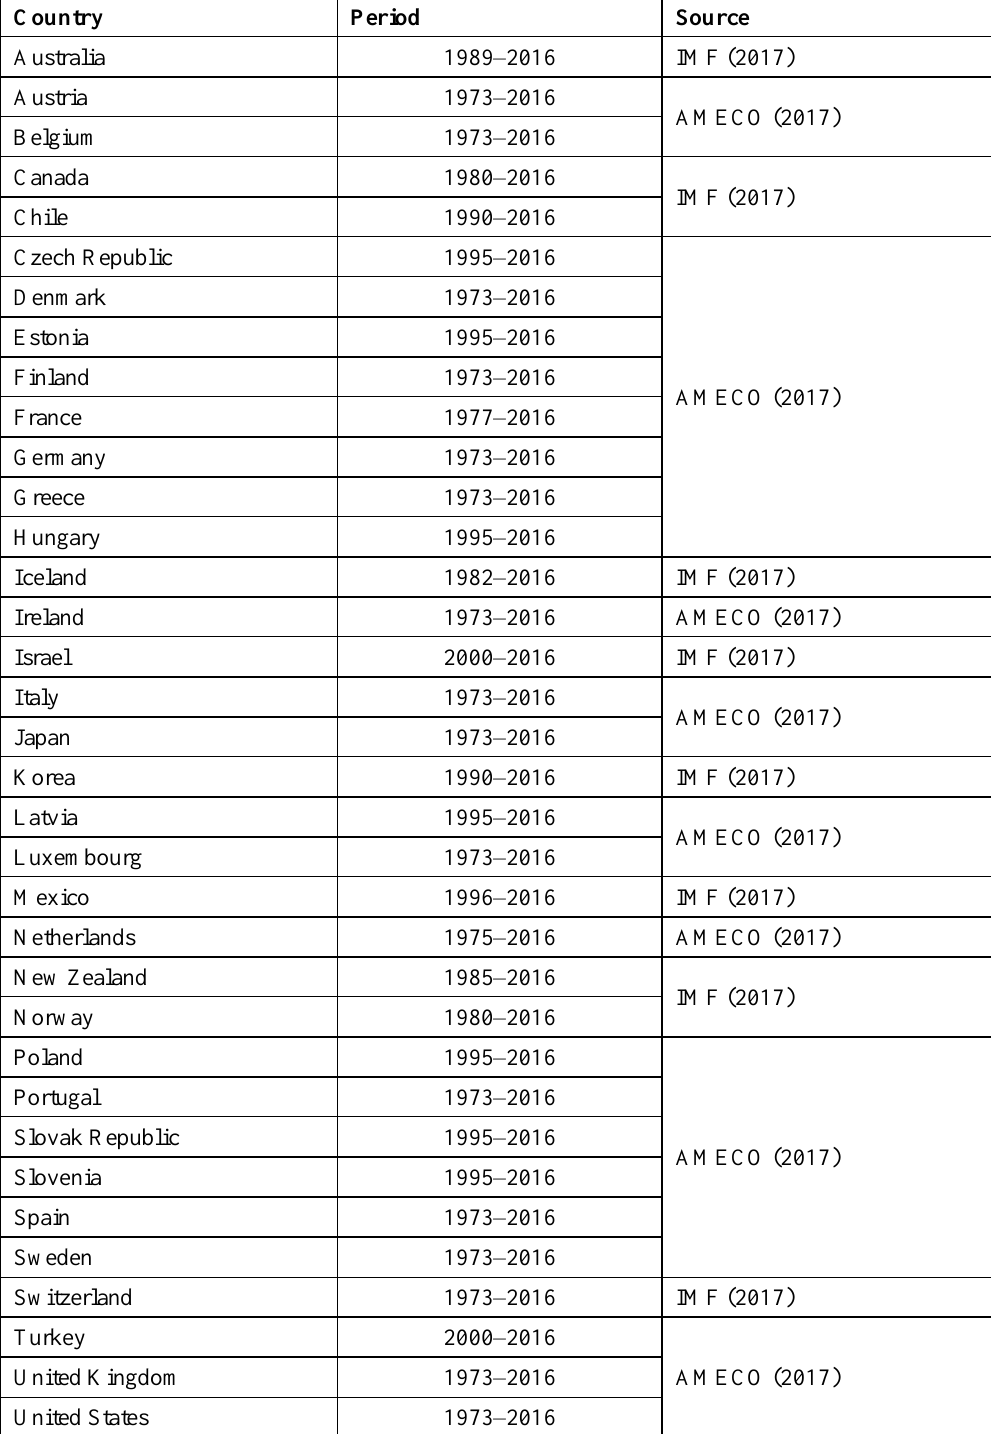
Table A1 . Public debt data